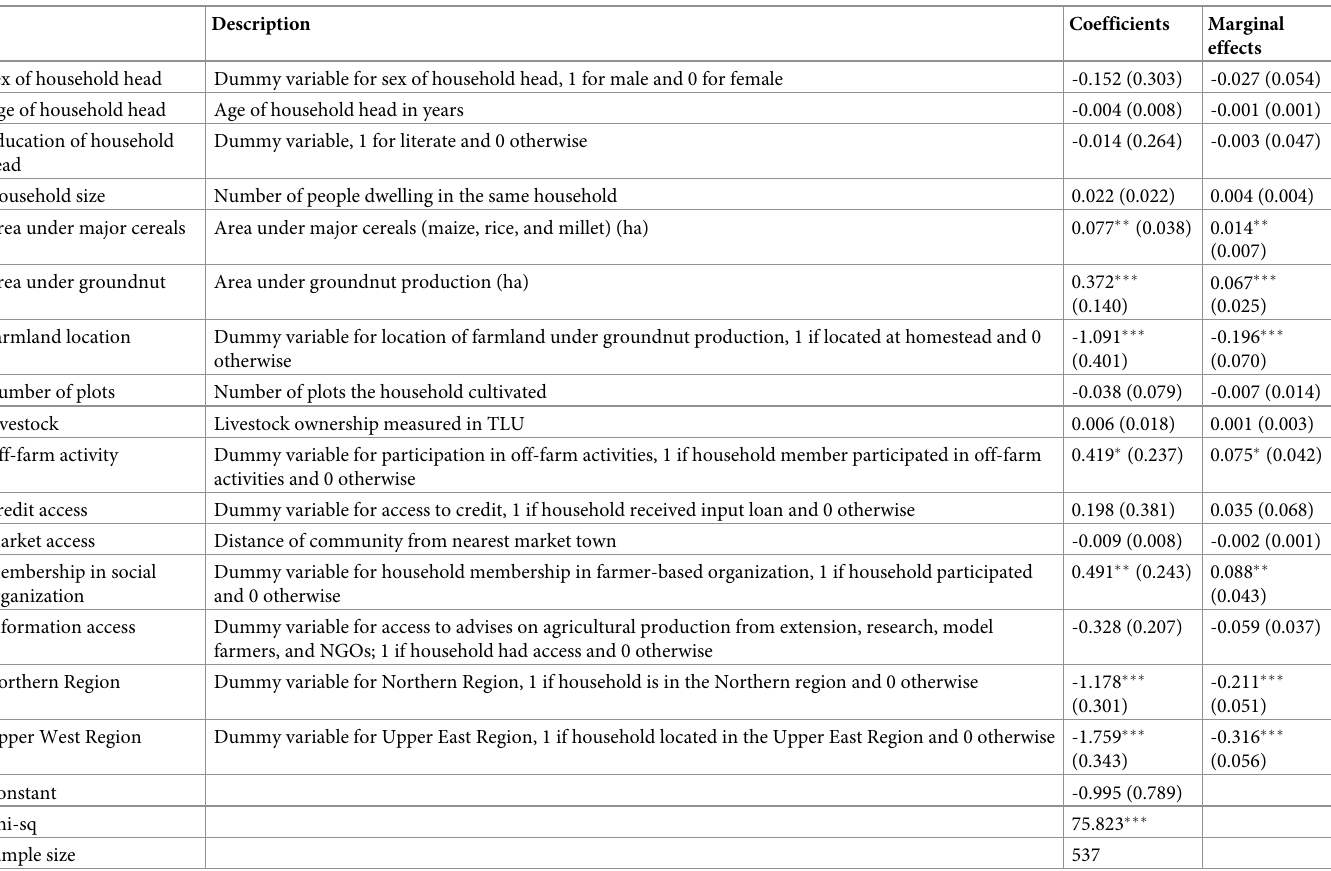
Table 2. Logistic model estimates of factors affecting adoption of improved groundnut